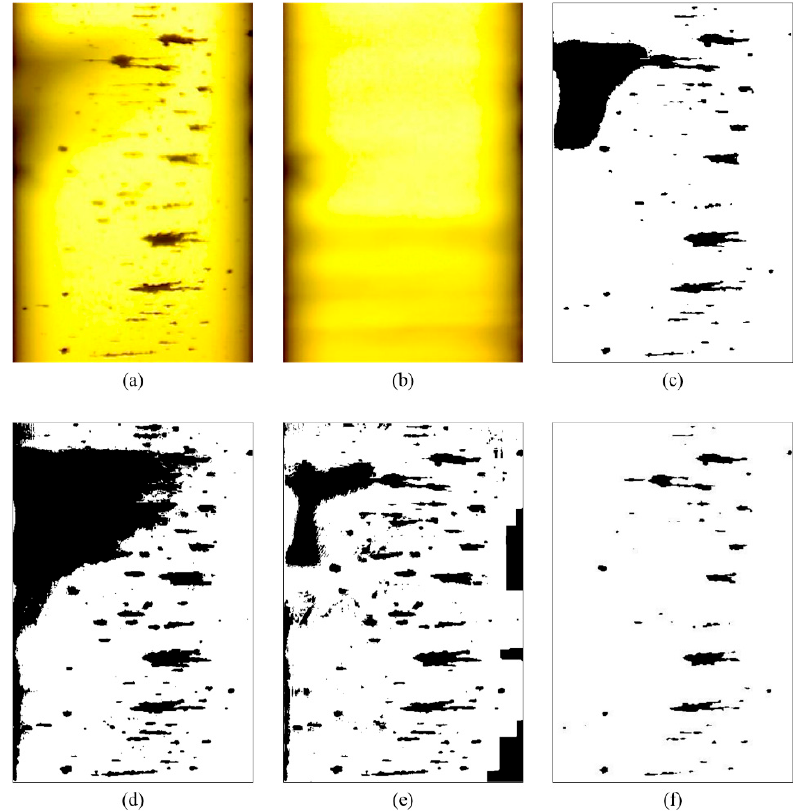
Figure 8. Comparison of the processing results of different binarization methods for a high-interference ferrogram. ( a ) Wear debris image of Figure 1a; ( b ) Background picture; ( c ) Otsu method; ( d ) Kittler method; ( e ) Niblack method; ( f ) the proposed method.